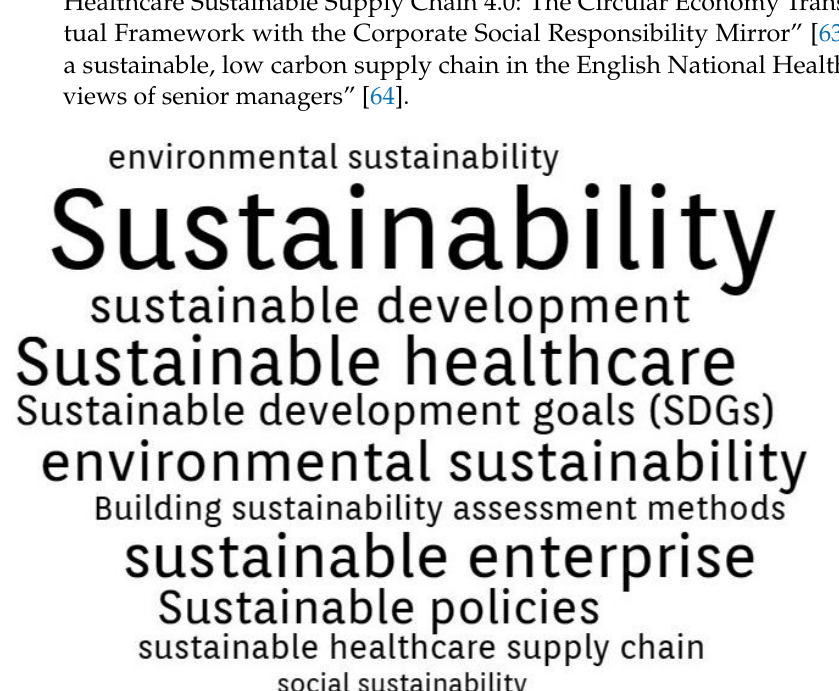
Figure 4. Sustainability cluster Authors’ Keywords.